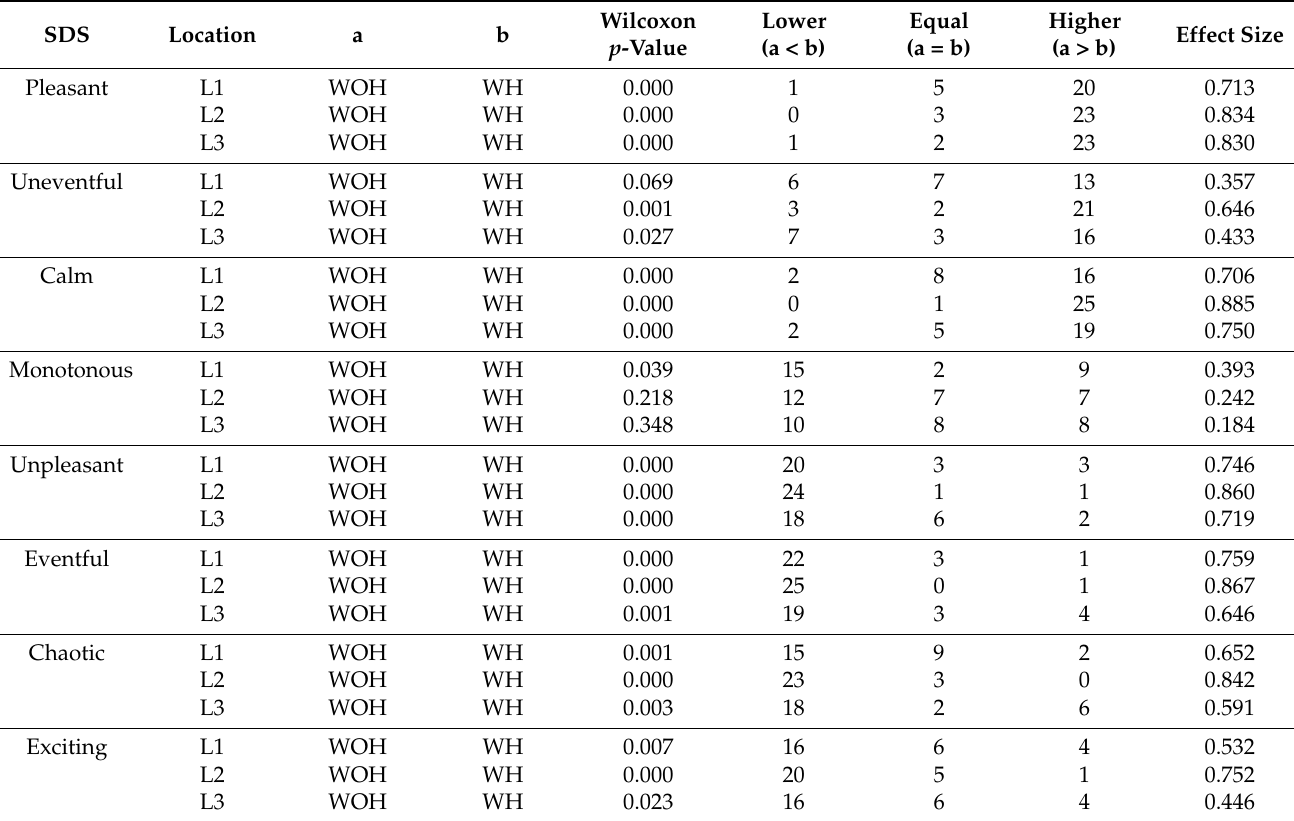
Table 3. Wilcoxon signed-rank test results ( p -value and comparison of ratings between paired variables) for the scenarios with (WH) and without helicopter noise (WOH) on the appraisals given to each SDS (pleasant, uneventful, calm, monotonous, unpleasant, uneventful, chaotic, and exciting). Results are shown for the three locations under study (L1, L2, and L3). For the analysis of the participants’ appraisals, “a” is the first, and “b” is the second variable of the